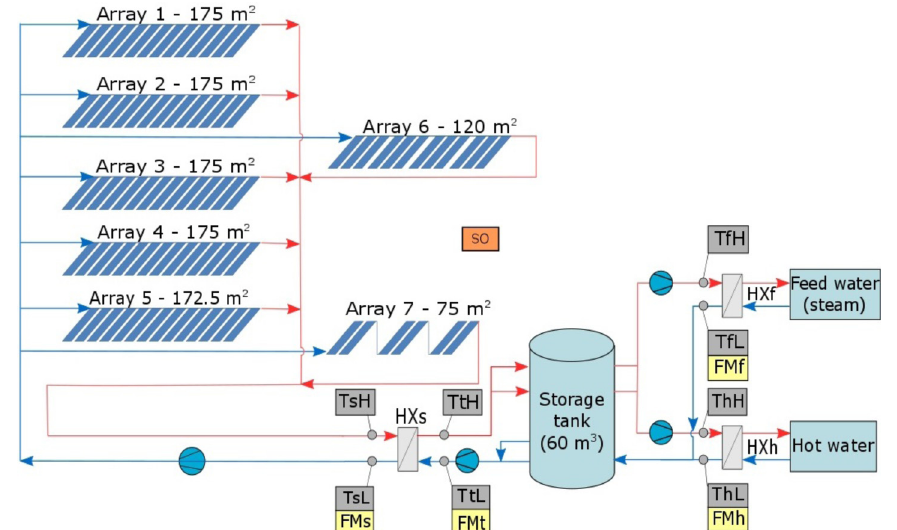
Fig. 1. Layout of the integration system. Temperature sensors are denoted by TxX (X = H, L for higher and lower temperature respectively; x = s, t, f, h for solar, tank, feed water and hot water circuit, respectively), fl ow meters by FMx, heat exchangers by HMx. Global irradiance on the tilted plane of the collectors is measured through a pyranometer, here denoted by